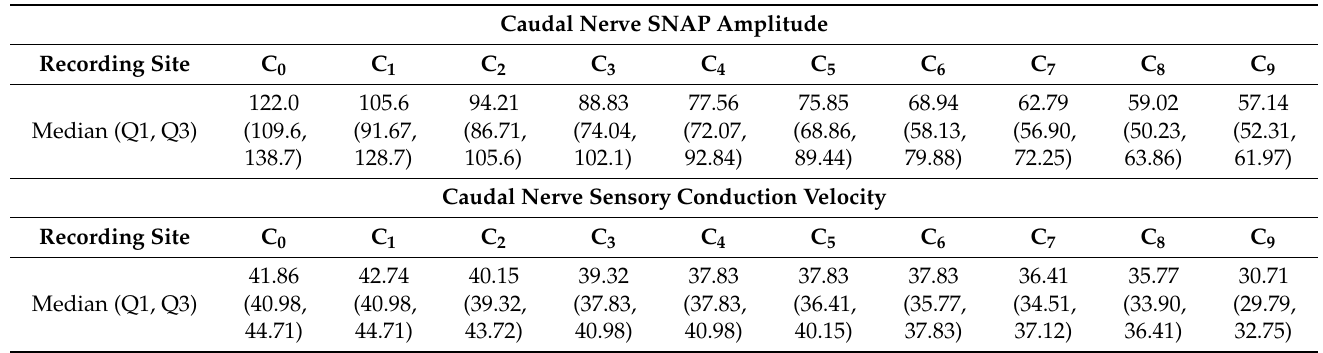
Table 1. Distribution of NCS values of the whole population at